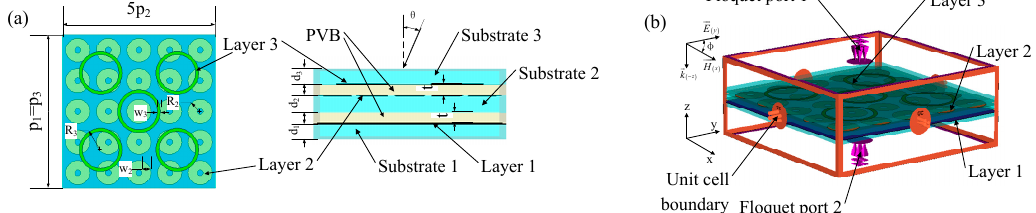
Figure 1. The structure of the absorber and the CST MWS simulation model. ( a ) The structure, ( b ) the CST MWS simulation model.